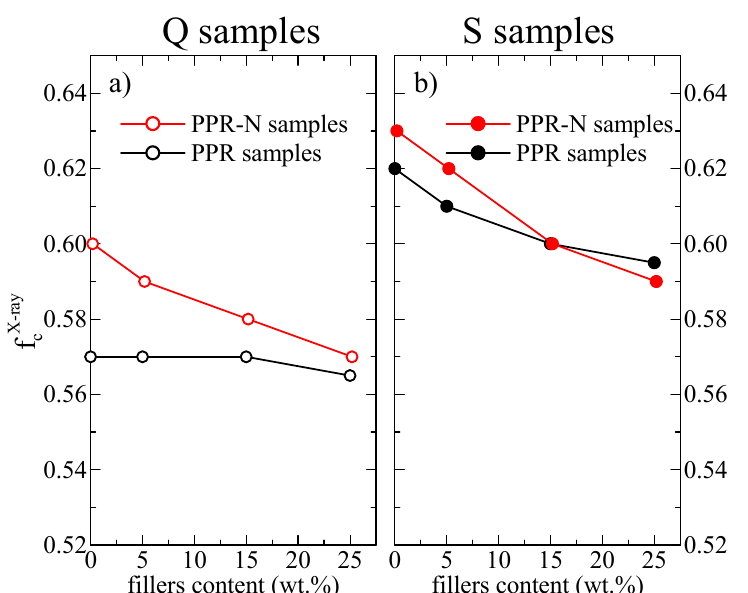
Figure 4. Results of the X-ray crystallinity as a function of the filler content (DSF and Millad nucleant): ( a ) Q samples; ( b ) S samples.